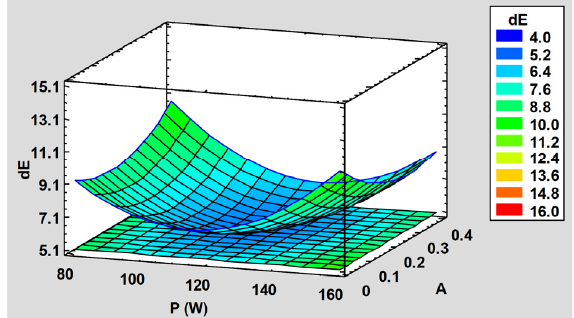
Figure 24. Effect of P and A on color change dE.